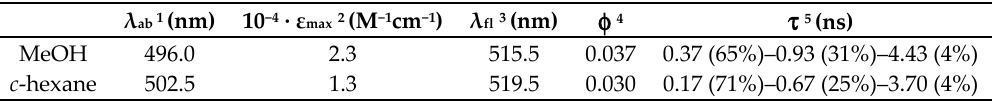
Table 1. Photophysical properties of C* -BODIPY 5 in diluted solution of apolar (cyclohexane) and polar (methanol)